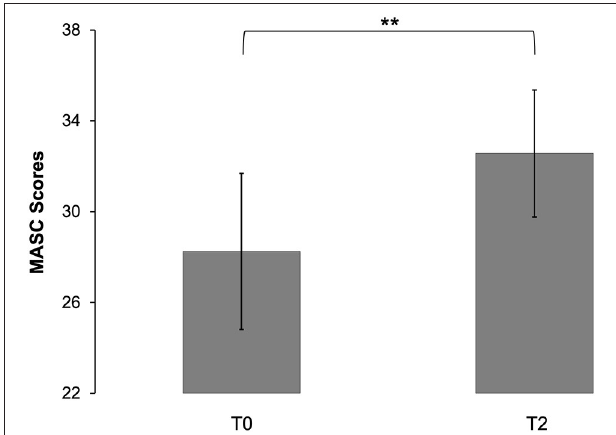
FIGURE 1 | Changes in mentalizing abilities from T0 to T2 measured with the Movie for the Assessment of Social Cognition (MASC). Error bars indicate the 95% confidence interval; ** p <